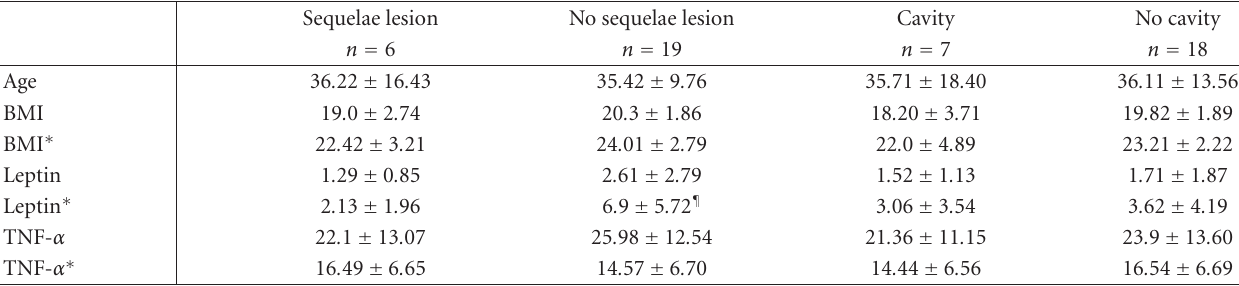
Table 4: Serum leptin and TNF- α levels in patients with sequelae lesions and cavitary tuberculosis. Data presented as mean ±